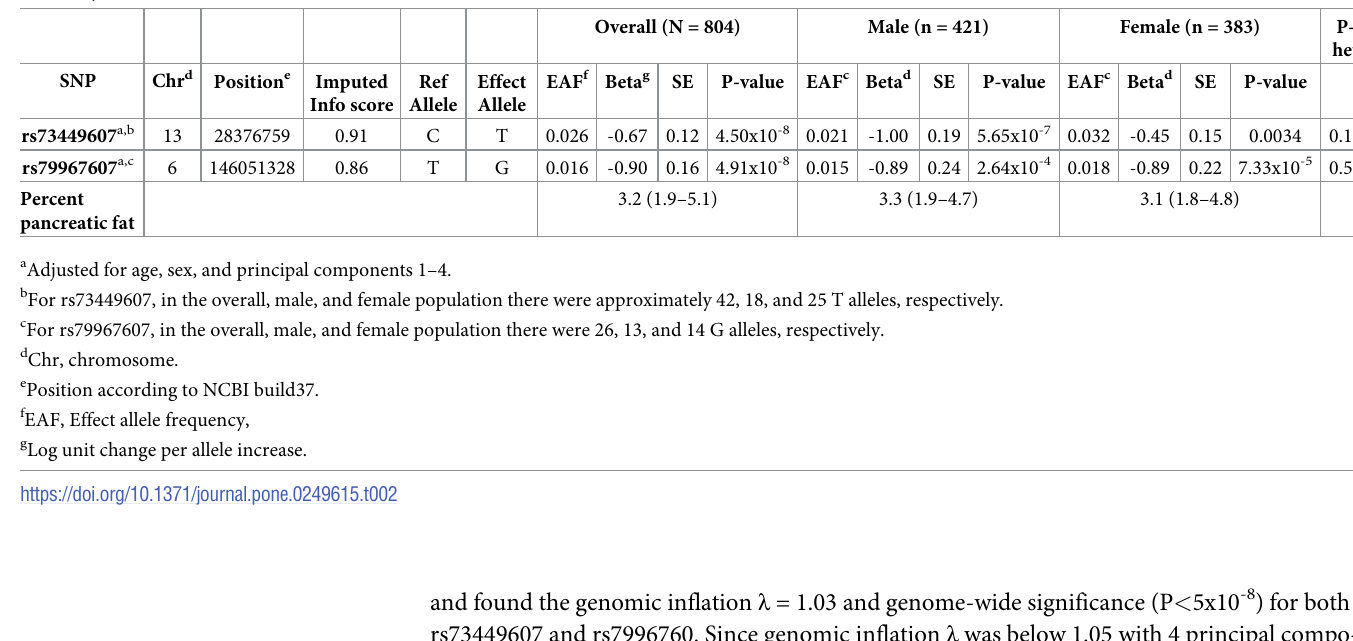
Table 2. Two genetic variants associated with percent pancreatic fat in the MEC-APS (P < 5 x 10 − 8 ) and median (interquartile range) of percent pancreatic fat, over- all and by